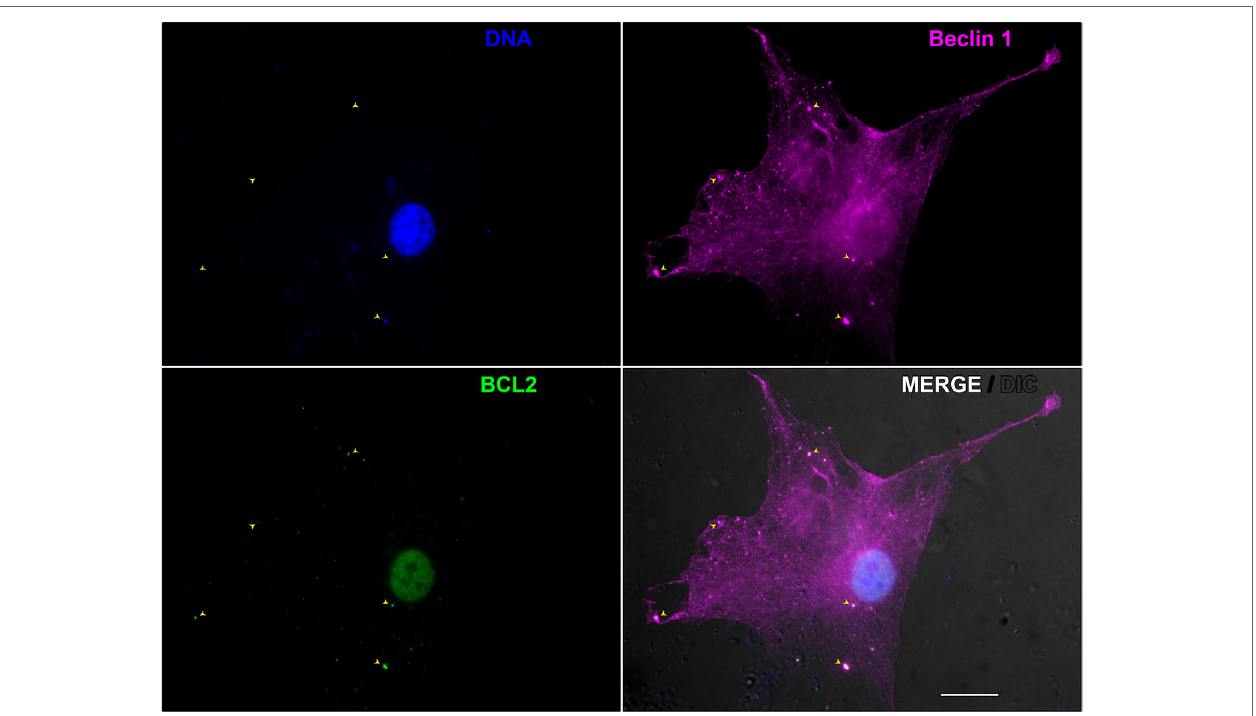
FiGURe 2 | Beclin 1-mediated autophagy during Mycobacterium leprae infection in skin lesion-derived lepromatous macrophage. Macrophages were isolated from the skin lesion of a lepromatous leprosy patient and cultured for 18 h in full nutrient medium. Cells were fixed and immunofluorescence for Beclin 1 (magenta) and BCL2 (green) was performed. Cellular and bacterial DNA were stained with DAPI (blue). Cell and mycobacteria morphology are shown by Nomarski differential interference contrast (gray). This image shows a lepromatous tissue macrophage interacting with M. leprae . BCL2 colocalizes with Beclin 1-entrapped mycobacteria (arrowheads) allowing M. leprae survival through autophagy inhibition. The modulation of autophagy has the potential to be useful in the leprosy treatment, as well as to prevent leprosy reactional episodes. Scale bar: 20